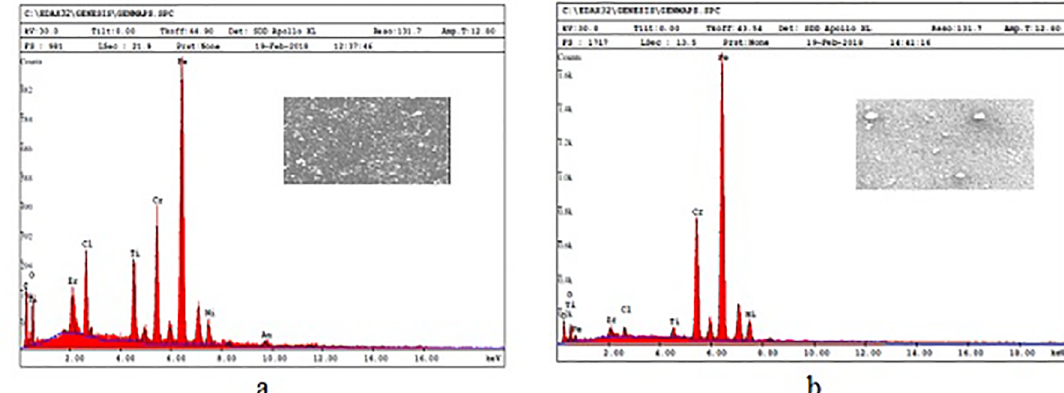
-ZrO coating with a mix ratio of 0.3:0.7 containing 2 wt. % nanoparticles after the corrosion test. 2 2